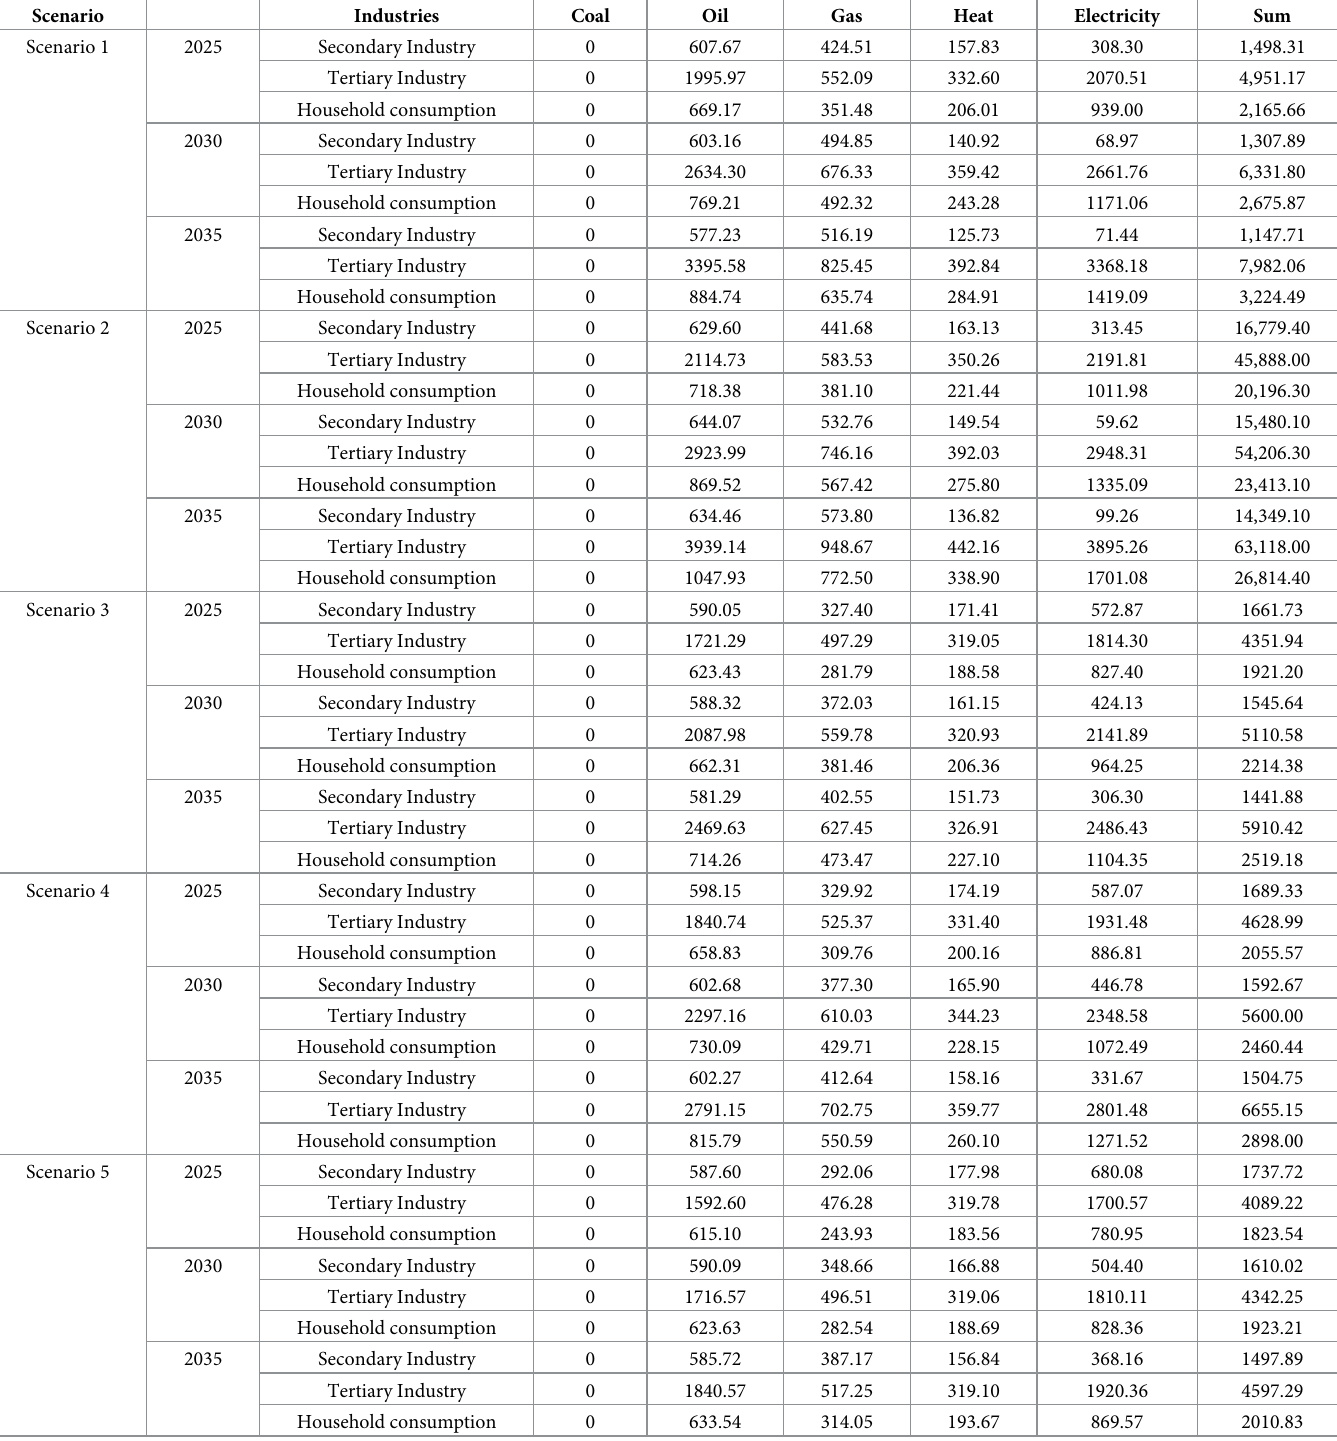
Table 9. Forecast values of terminal energy consumption by energy and industry